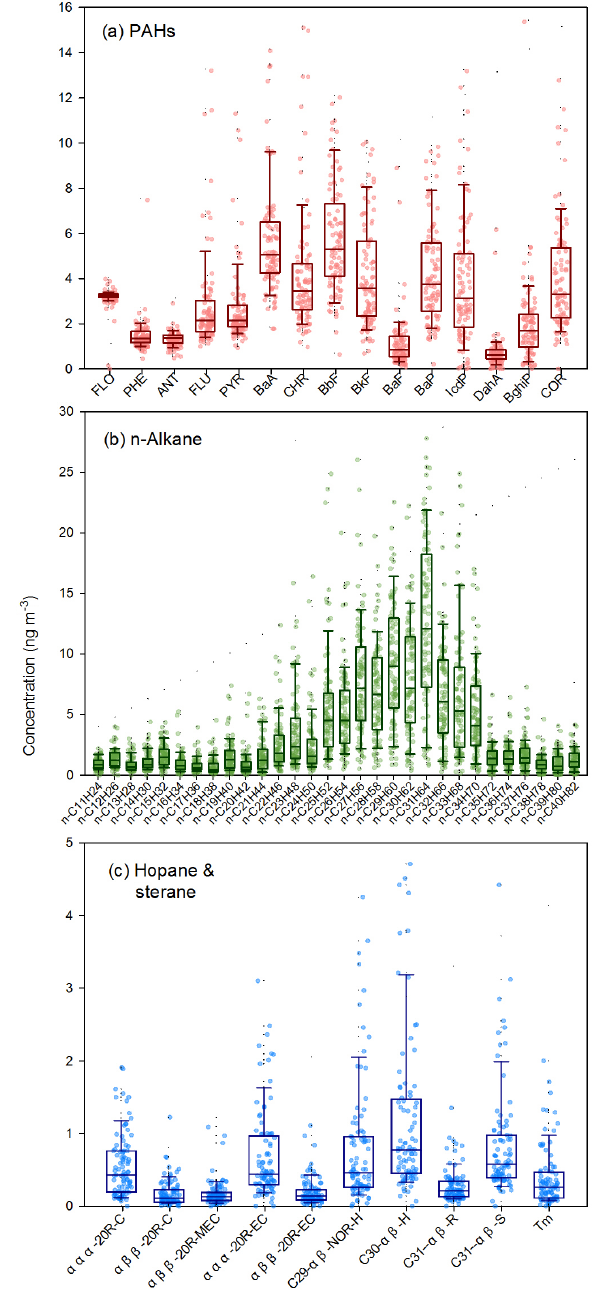
Figure 3. Concentration profiles of NPOCs.